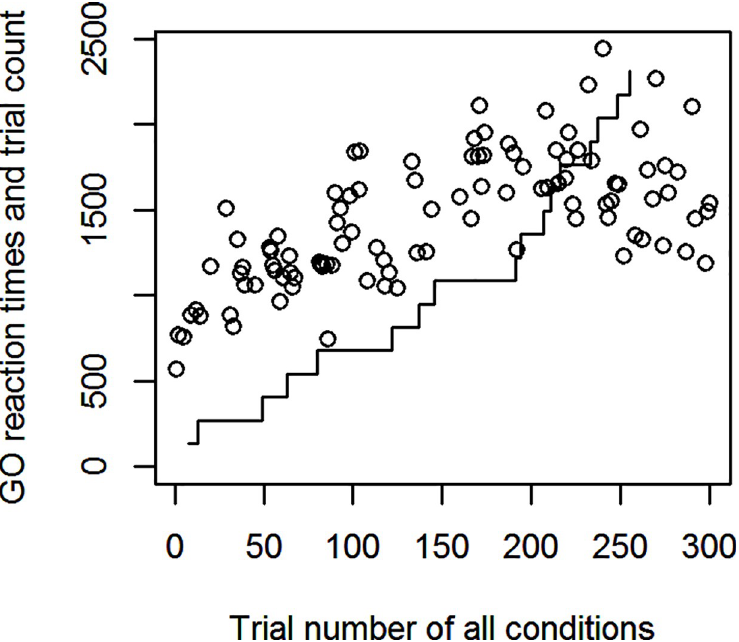
Fig 9. Go-RT slowing in Experiment 2. As Fig 1, a participant’s Go-RTs for one condition in the PSI adjusted method’s block. The line indicates the increasing number of Change-trials, the circles are Go-RTs.